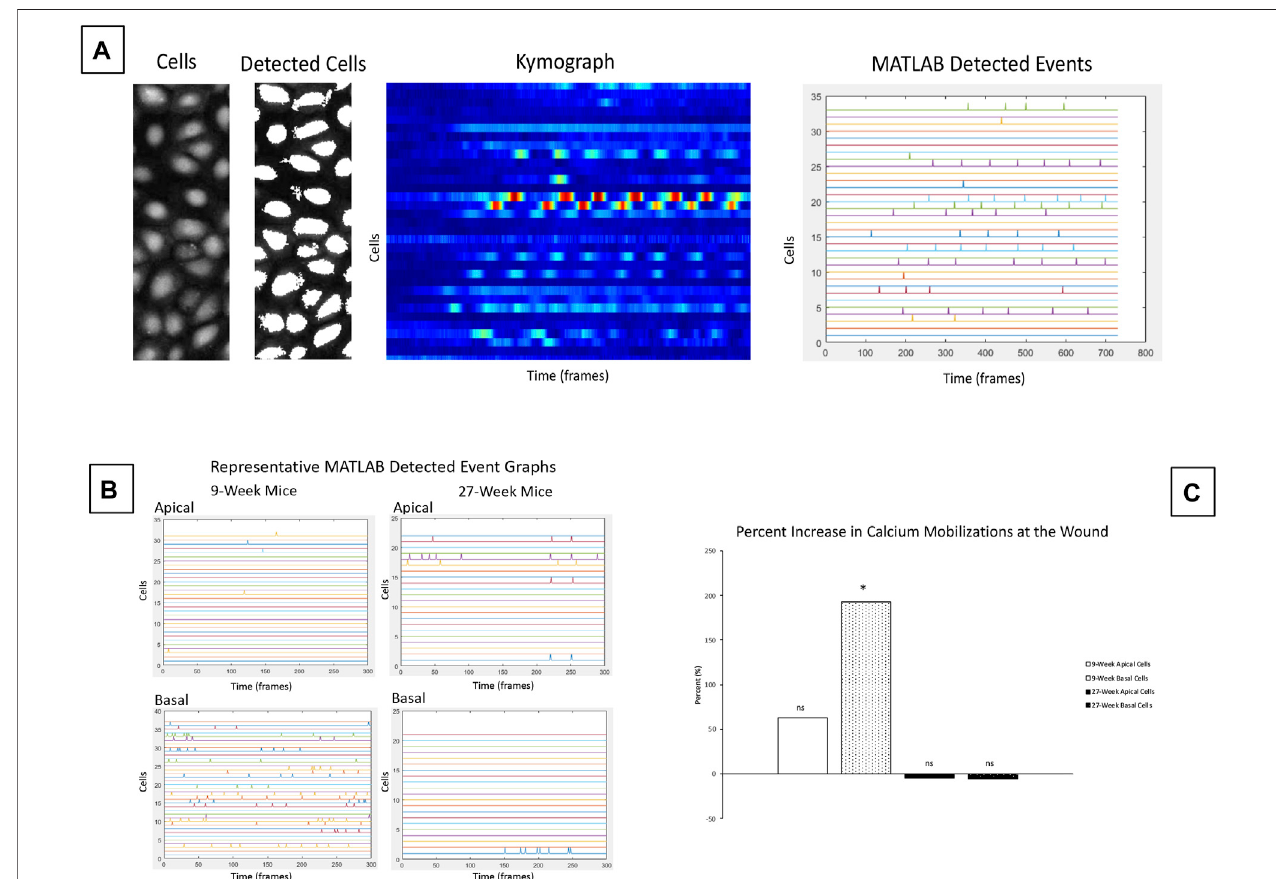
FIGURE 5 | Calcium signaling events occur in basal cells adjacent to the wound in corneas from 9-week mice. Calcium signaling events were monitored in apical and basal layers of the corneal epithelium after injury. (A) Schematic of cell-based approach for calcium analysis shows a representative image of cells, and detection of these cells by MATLAB using coordinates from the video. The changes in intensity of each cell over time are shown using a kymograph. MATLAB detected events were identi fi ed from the kymograph as changes in intensity greater than a threshold of 40% of maximum intensity. (B) Representative MATLAB detected events from basal and apical z-planes of corneal epithelium. (C) Mean percent change of the signaling events for apical and basal layers of the age cohorts. The data represent four eyesper condition,witheach eyefromonemouse. Dataaremeans±SEM.There weresigni fi cantlymore detected signaling eventsinthebasalcellsin9-weekcorneas. (Two-tailed paired Student ’ s t-test comparing signaling events at the wound to background signaling at the same Z-plane; * p < 0.05). No signi fi cant differences over background were detected between apical cells from either age cohort or between basal cells from older mice.